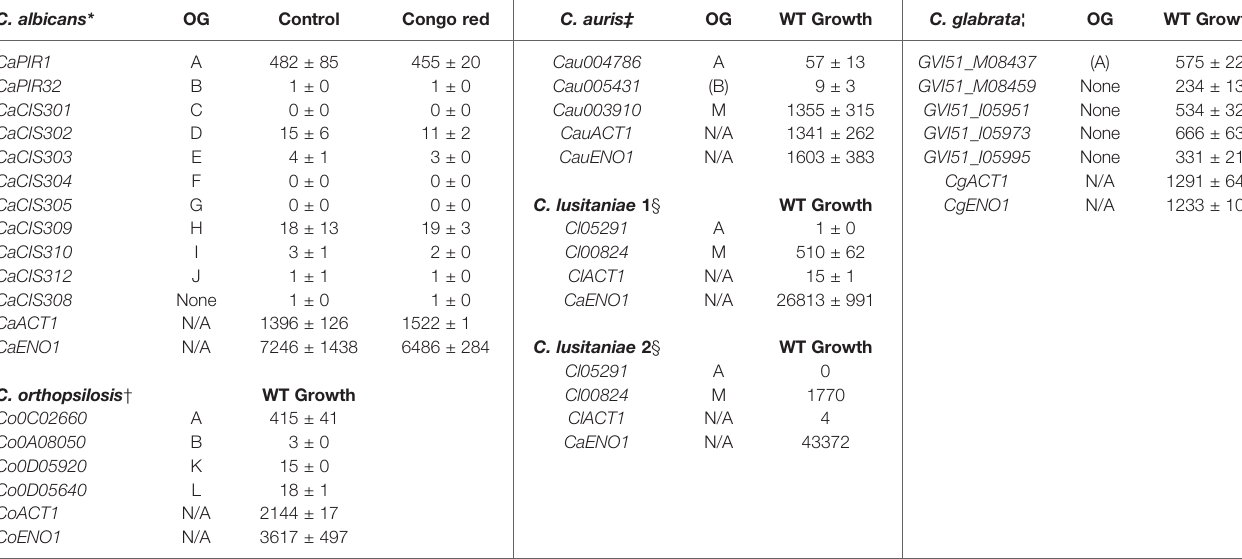
TABLE 3 | Relative gene expression levels from RNA-Seq datasets available on the NCBI Sequence Read Archive. OG